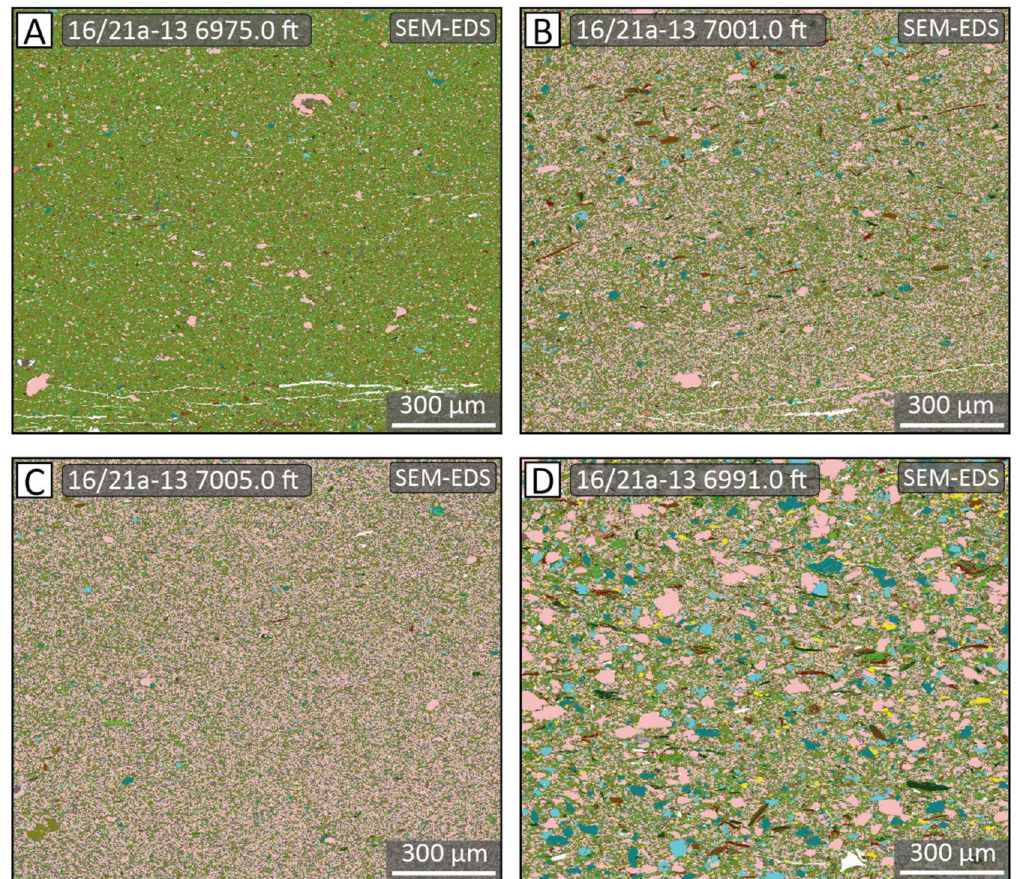
Figure 11. High-resolution SEM-EDS images of the Lista Shale in well 16 / 21a-13, presented in order of increasing quartz concentration. These images reveal the mineralogy of samples but the pores in these shales are beyond the resolution of the SEM-EDS device (approximately 1 to 2 µ m minimum resolution). The key to relate the selected colours to mineral type is shown in Figure 10. Calcite is absent in all samples. ( A ) Core depth 6975 ft: smectite (83%) and quartz (10%), with quartz present as silt-sized grains ( B ). Core depth 7001 ft: smectite (56%), quartz, (34%) dominate this sample with minor biotite. ( C ) Core depth 7005 ft: fine quartz silt (63.9%) dominates this sample with 30% smectite. ( D ) Core depth 6991 ft: smectite (56%) and coarse quartz silt (34%) dominate this sample that is also rich in plagioclase (4.3%) and K-feldspar (5.6%) silt-grade material.